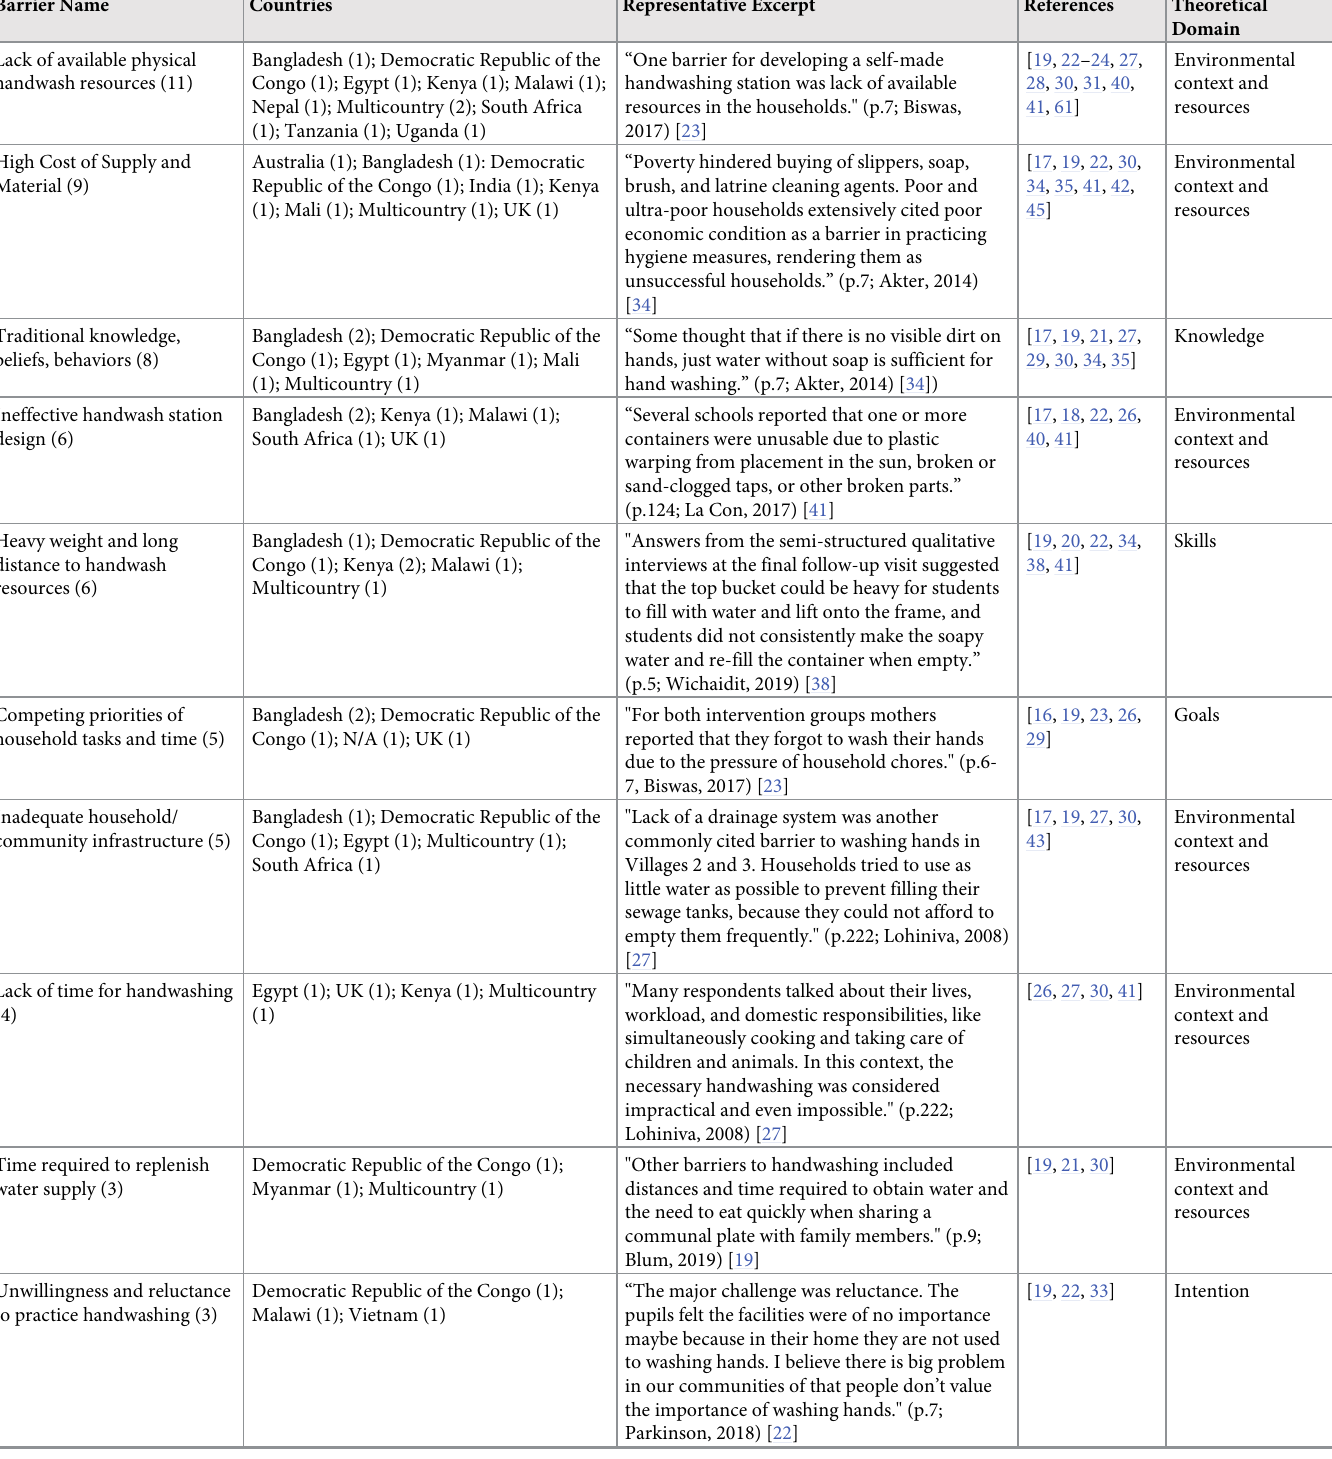
Table 2. Barriers identified from the 46 studies categorized into domains of the Theoretical Domains